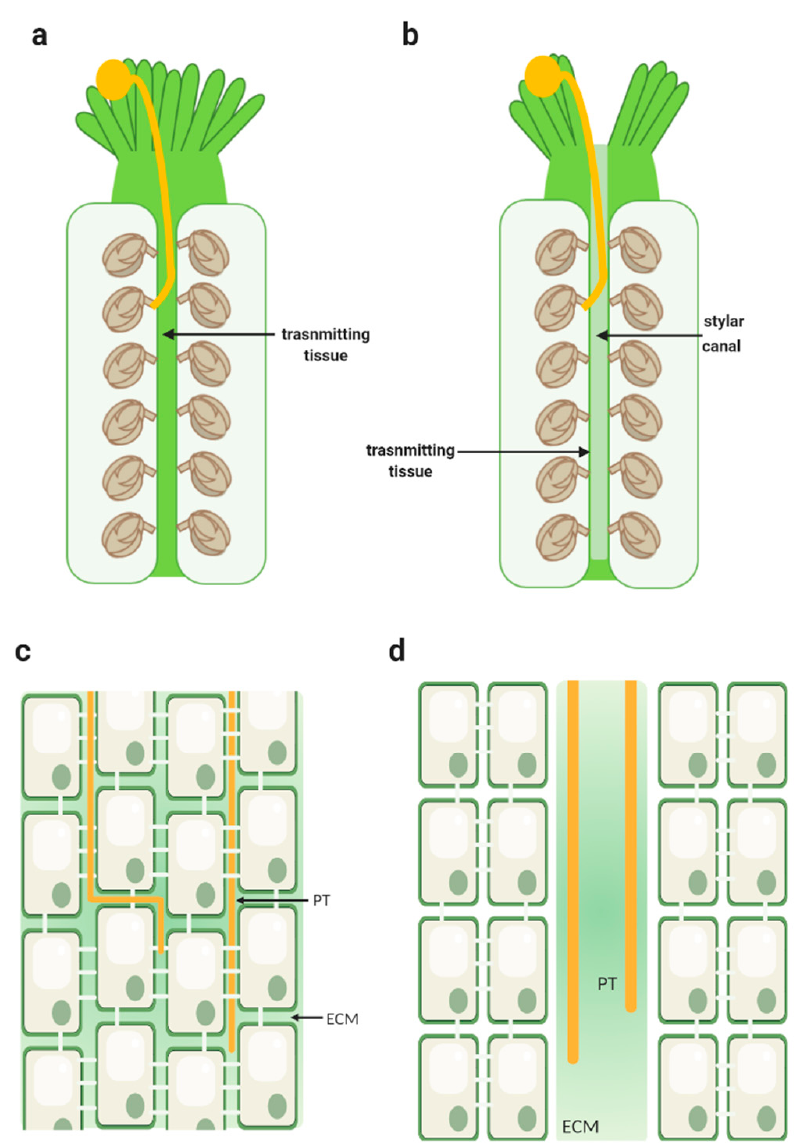
Figure 1. Schematic representation of a closed and an open style. ( a ) Longitudinal section of a closed style showing a continuous strand of transmitting tissue inside the pistil. A pollen grain is represented germinating in the stigmatic cells, with a pollen tube (in yellow) growing through the transmitting tract tissue towards the ovules. ( b ) Longitudinal section of an open style showing a continuous stylar canal lined with a secretory epidermis. A pollen grain is shown germinating in the stigmatic cells, with a pollen tube (in yellow) directing towards the ovules at the surface of the canal cells. ( c ) Longitudinal section of a part of the transmitting tissue from a closed style exhibiting the presence of substantial intercellular spaces filled with the extracellular matrix. Elongated cells are shown; they are connected through each other by the plasmodesmata in its transverse walls. Pollen tubes (PT) (shown in yellow) are displayed growing between the cells, in the extracellular matrix (ECM). ( d ) Longitudinal section of an open style showing the epidermal layer of secretory cells lining a canal filled with extracellular matrix (ECM); the pollen tube (PT) is yellow. Created with BioRender.com.